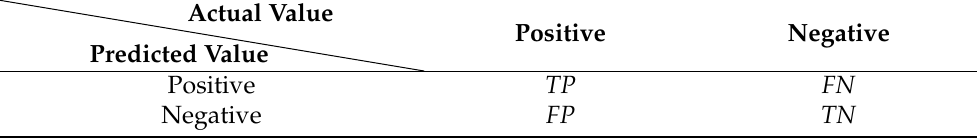
Table 2. Four combined results of between the predicted value of the model and actual